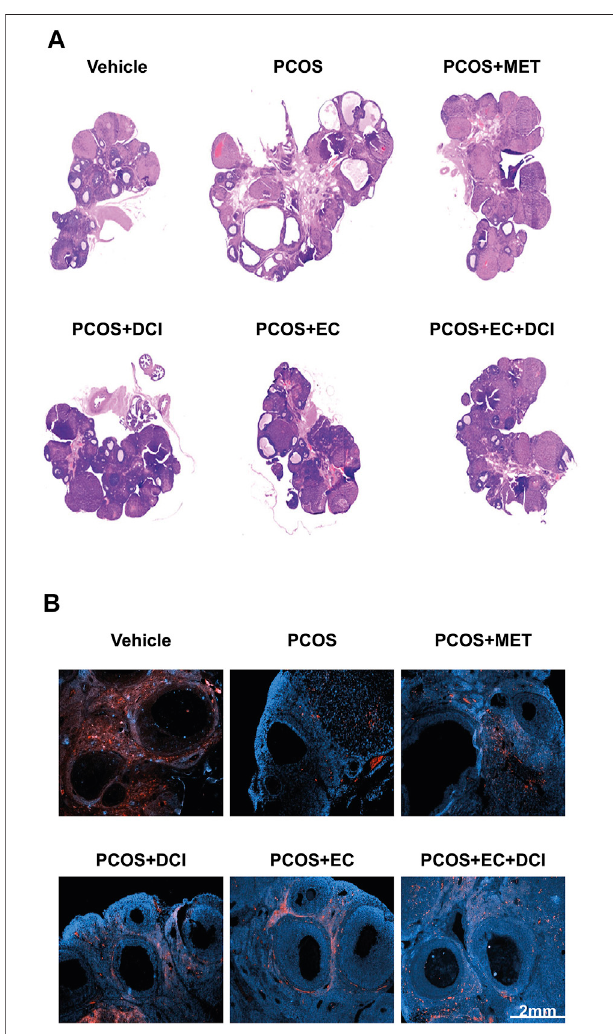
FIGURE 6 | Effect of EC extract and DCI on aromatase localization and histological changes in the ovary of PCOS rats. (A) H&E-stained ovarian tissue was scanned with a slide scanner (3D HISTECH Ltd., Budapest, Hungary). Magni fi cation×20.Sectionofovarywasperformedimmunohistochemistry using speci fi c aromatase (B) antibody; 2nd Ab was rabbit (Scale bar = 2 mm), counterstained with DAPI. Magni fi cation ×200.